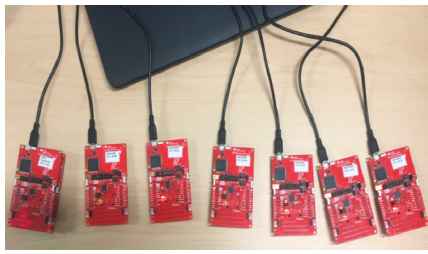
Figure 6: Physical view of the six-hop